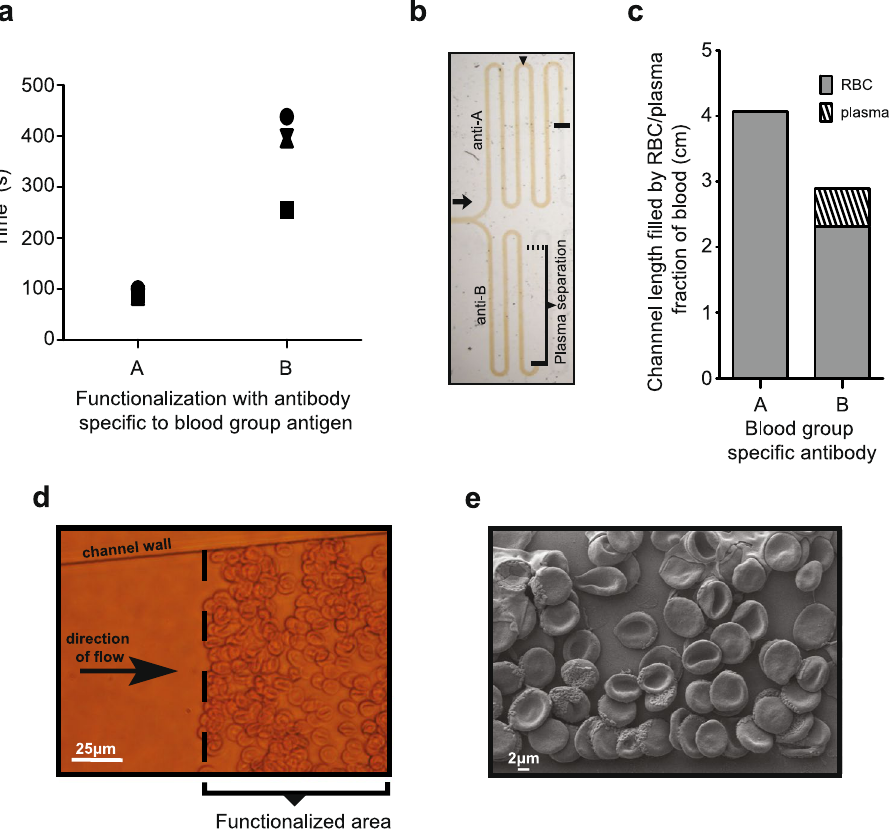
Figure 2. RBC retardation and plasma separation. ( a ) Graph shows the time that needed for a blood group B blood to reach the second loop (indicated by arrowhead in panel b) in the two arms functionalized by anti-A or anti-B group specific antibodies. The experiment was repeated 4 times, data pairs of the same run are represented by identical symbols. ( b ) A picture taken at the end of experiment (7 min) shows that the plasma separated from red blood cells only in the arm that was functionalized by anti-B antibodies. ( c ) Graph presents the length of RBC or plasma of a blood group B blood in the two arms at the end of experiment. ( d ) Light microscopic and ( e ) SEM pictures shows that RBC’s binds to the functionalized